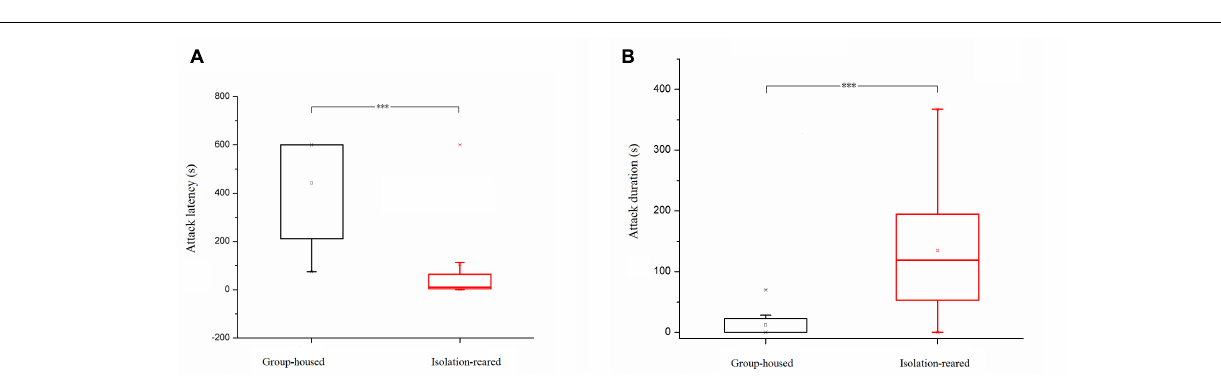
FIGURE 4 | Box plots of attack latency and duration in the resident–intruder tests. (A) Attack latency of isolation-reared and group-housed mice. (B) Attack duration of isolation-reared and group-housed mice. ∗∗∗ Indicate p < 0.001. Bar represent minimum or maximum. (cid:3) Represent